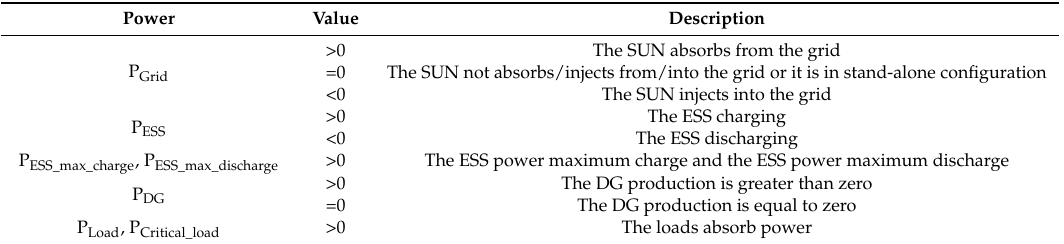
Table 1. Sign convention.